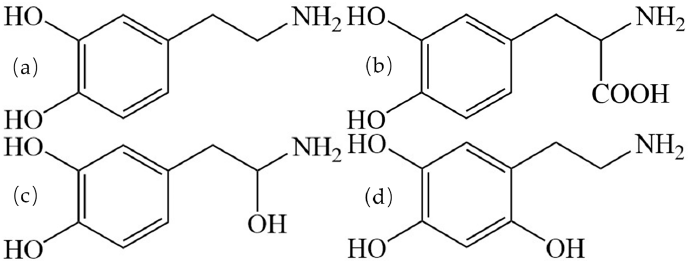
Figure 1. Molecule structures of (a) dopamine, (b) levodopa, (c) norepinephrine, and (d) 6 ‐ hydroxydopamine.